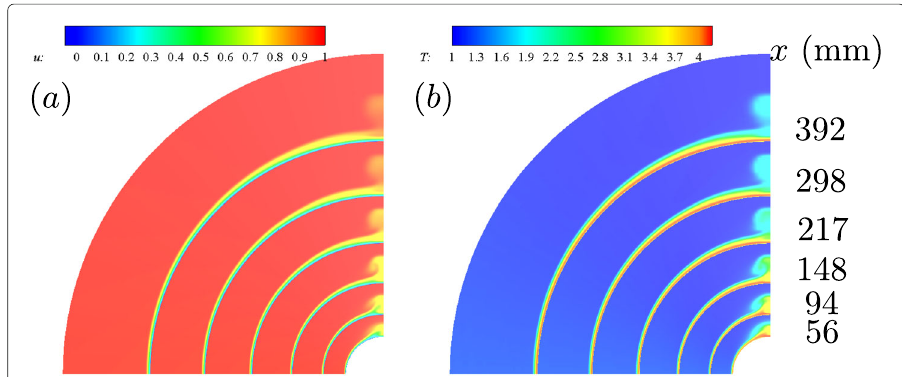
Fig. 2 Axial slice of nondimensional u and T on the leeward side of undisturbed basic state computed by second order finite volume